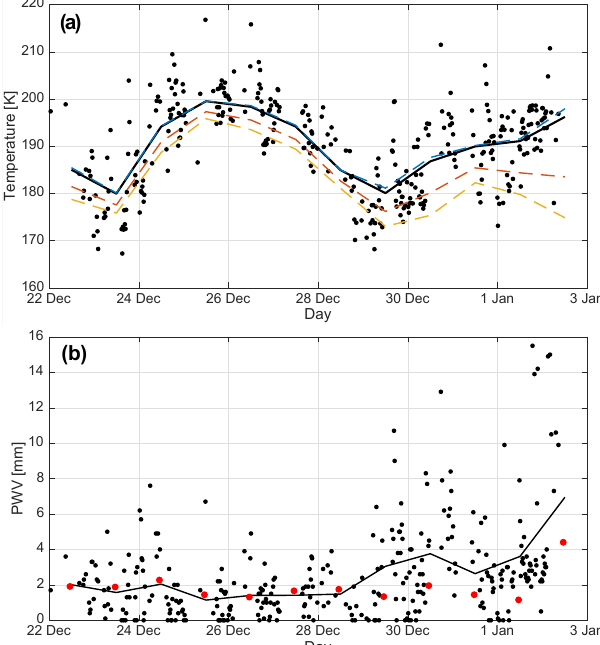
Figure 9. Panel (a) : OH(8–3) temperatures obtained using Hi- TIES. Each black point is obtained from a spectrum composed of 20min of integration time. The solid black line is the daily mean. The coloured dashed lines represent the daily mean temper- atures obtained when water vapour absorption is not taken into ac- count. Temperatures obtained from the line ratio P 1 (2) / P 1 (3) are shown in blue, those from P 1 (2) / P 1 (4) are in red, and those from P 1 (3) / P 1 (4) are in yellow. Panel (b) : precipitable water vapour (PWV) obtained during each temperature calculation shown in panel (a) , represented by black points. The daily mean of these is plotted in a solid black line. The red points represent PWV de- termined from the humidity profiles measured by the daily Ny- Ålesund radiosonde measurements (Maturilli and Kayser, 2016). These data were recorded in December 2003 and January